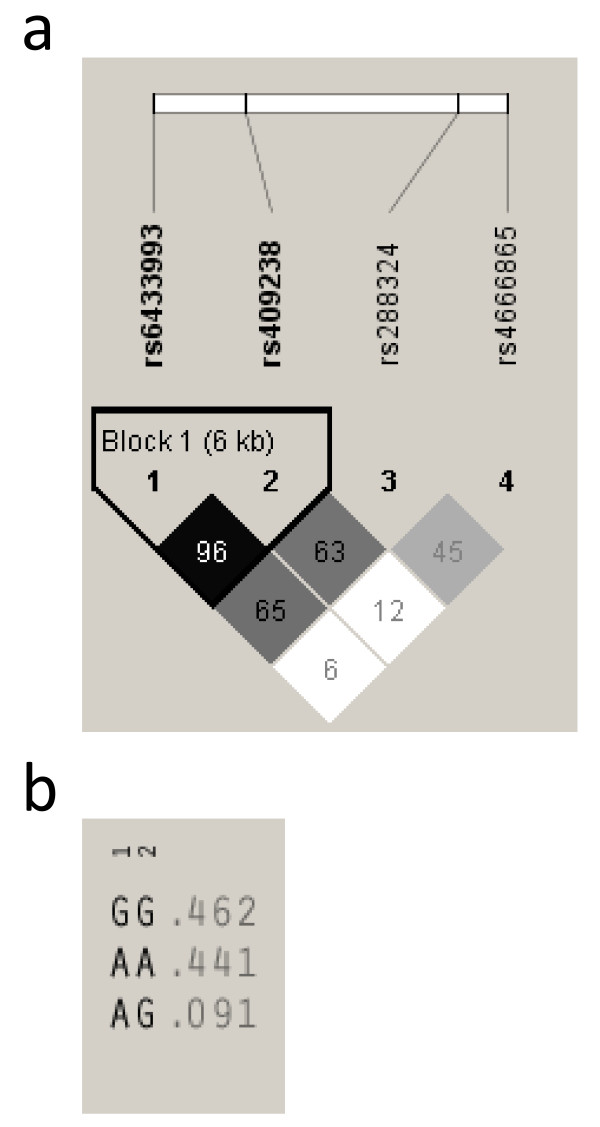
Linkage disequilibrium (LD) patterns and haplotype frequencies for the FRZB gene. Block structures depicted by Haploview. The increasing degree of darkness of the cells from white to black represents the increasing strength of LD. The values in the cells are the pair-wise degrees of LD indicated by D' × 100 when D' < 1. In the figure, 1 to 4 represent rs6433993 rs409238 rs288324 and rs4666865 respectively. The haplotype frequency is denoted beside each corresponding haplotype and calculated from unrelated parents (n = 1602). a LD pattern for the FRZB gene. b Haplotype frequencies for the FRZB gene.